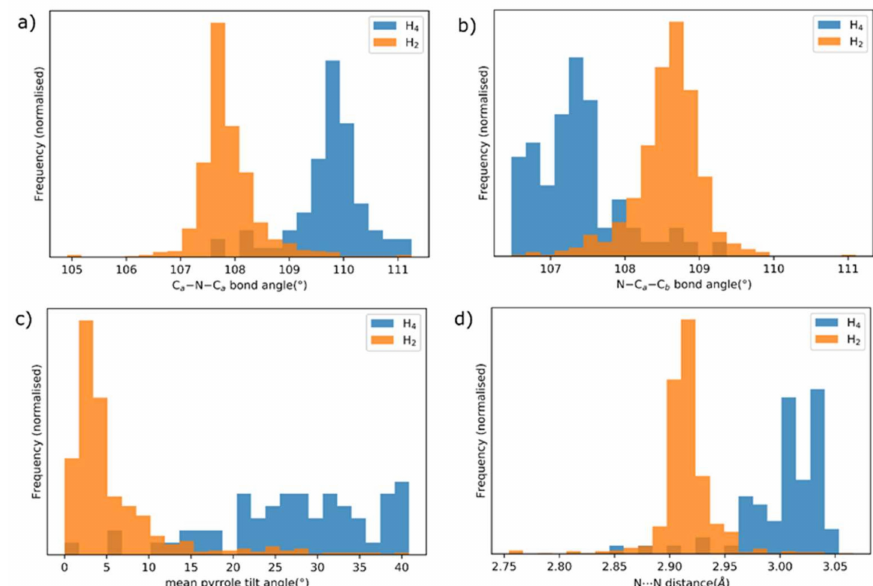
Figure 4. Normalized histograms of selected mean bond distances, angles and derived parameters for the populations of free base porphyrins (orange) and porphyrin dications (blue) for crystal structures reported in the CCDC CSD: ( a ) the C a -N-C a angle, ( b ) the N-C a -C b angle, ( c ) inclination of the mean plane of each pyrrole from the porphyrin mean plane, ( d ) adjacent N ··· N separation (e.g., N21 ···